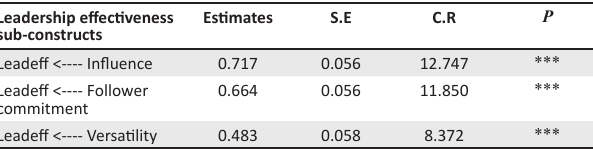
TABLE 7: Structural model parameter estimates and p -values for leadership effectiveness and its sub-constructs.